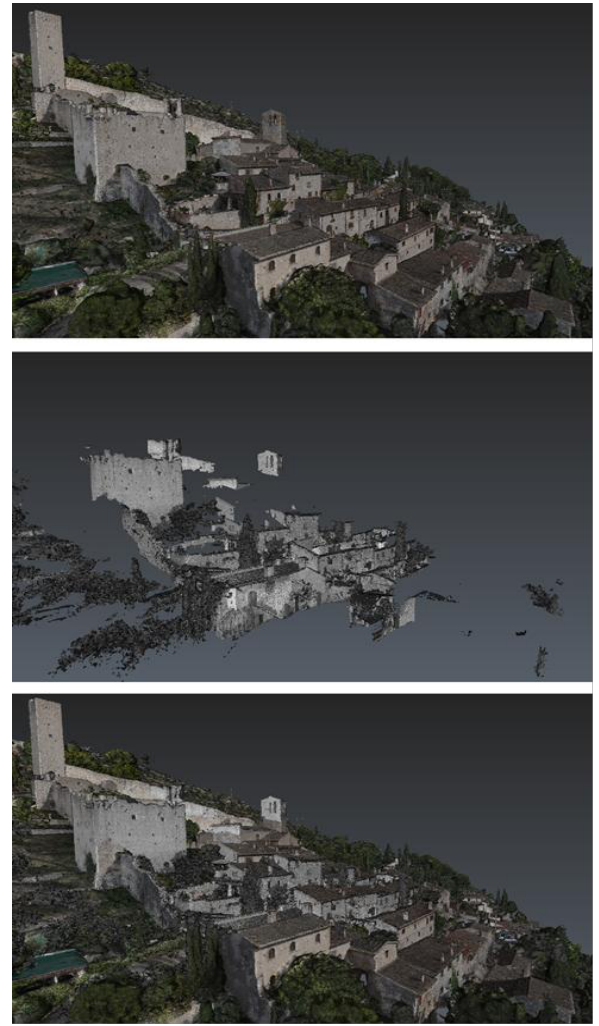
Figure 8. Connection of the clouds of points through 3dReshaper 5. BIM E